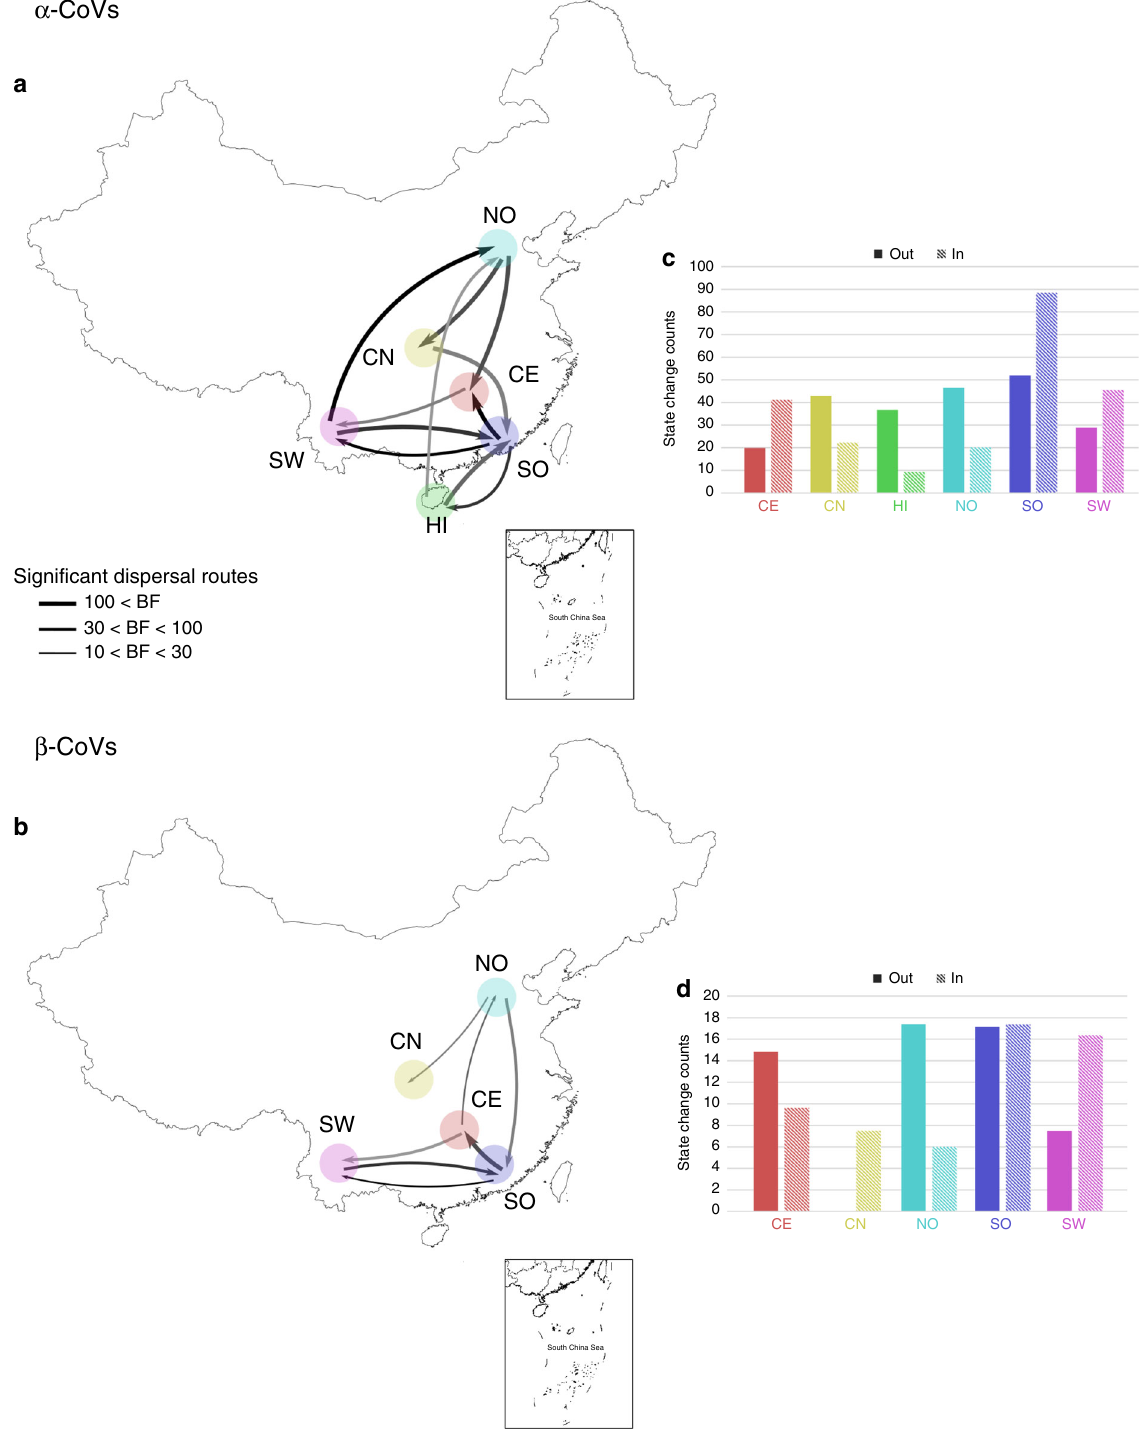
Fig. 6 CoV spatiotemporal dispersal in China. Strongly supported dispersal routes (Bayes factor, BF > 10) over recent evolutionary history among China zoogeographic regions for α -CoVs ( a ) and β -CoVs ( b ). Arrows indicate the direction of the dispersal route; arrow thickness is proportional to the dispersal route signi fi cance level. Darker arrow colors indicate older dispersal events. Histograms of total number of dispersal events (Markov jumps) from/to each region along the signi fi cant dispersal routes for α -CoVs ( c ) and β -CoVs ( d ). NO Northern region, CN Central northern region, SW South western region, CE Central region, SO Southern region, HI Hainan